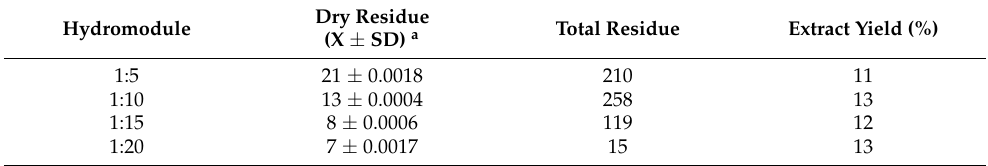
Table 1. Yield of the different hydromodules of the hydroalcoholic leaf extract of Vismia guianensis . Hydromodule